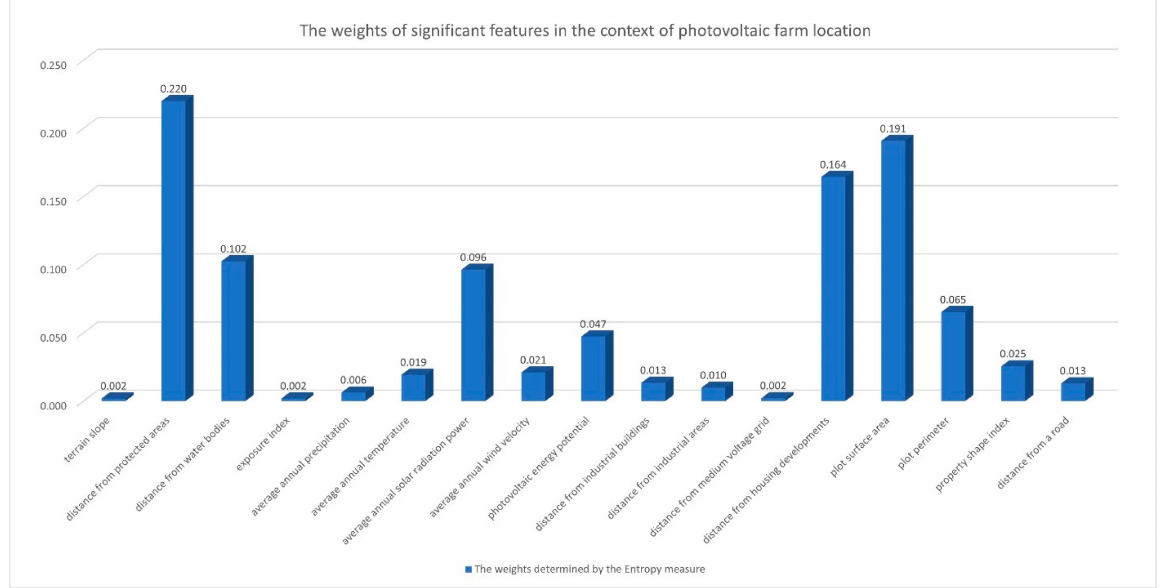
Figure 9. The weights of significant features in the context of photovoltaic farm location, determined by the entropy